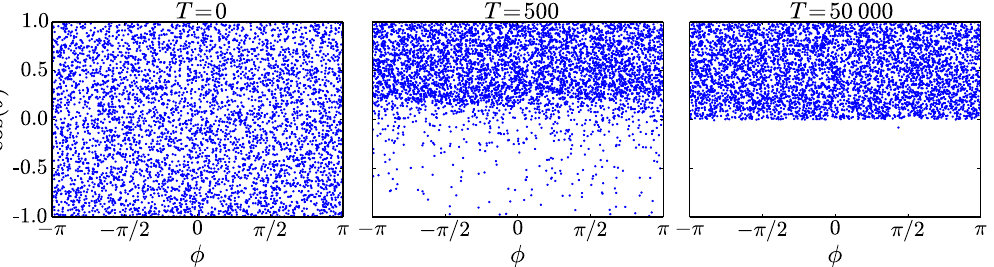
FIG. 5. Orientations of each of the N ¼ 5 × 10 3 agents at time T ¼ 0 , T ¼ 500 , and T ¼ 50 000 . We visualize the orientations by plotting the end points of the orientation vectors on the sphere S . The sphere is then mapped onto a rectangle using an area-preserving transformation. We choose the z axis along ρ , and arbitrarily choose mutually orthogonal x and y axes. θ then represents the angle measured from the z axis (cos θ ¼ ˆ ρ · σ ), and ϕ represents the azimuthal angle measured anticlockwise from the x axis. The agent state vectors are initialized with a uniform distribution on the sphere and evolved with a coupling constant K ¼ 0 . 1 . Note how all of the agents tend to uniformly distribute themselves on one hemisphere.